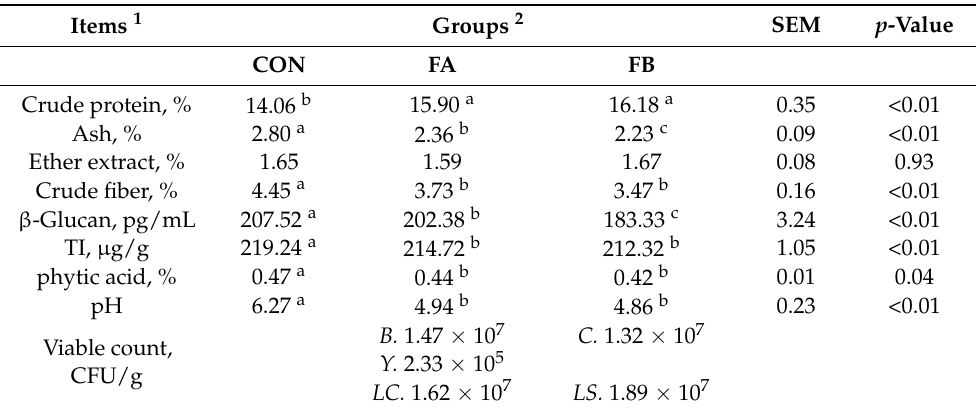
Table 3. The nutrient composition of feed before and after